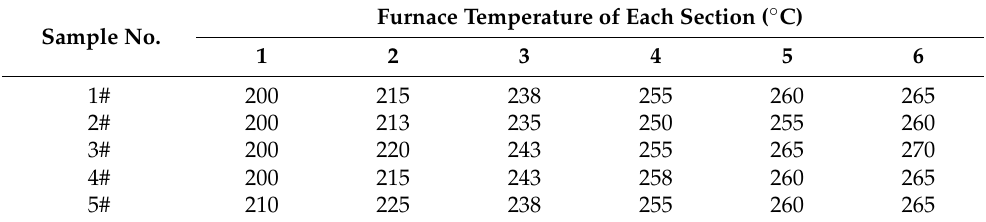
Table 2. Pre-oxidized fiber prepared at different heat treatment